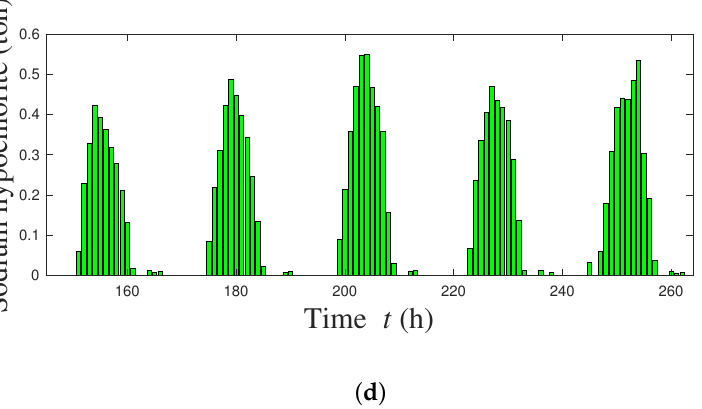
Figure 5. Simulation results of case 2. ( a ) The per hour PV generation. ( b ) The trends of PV power